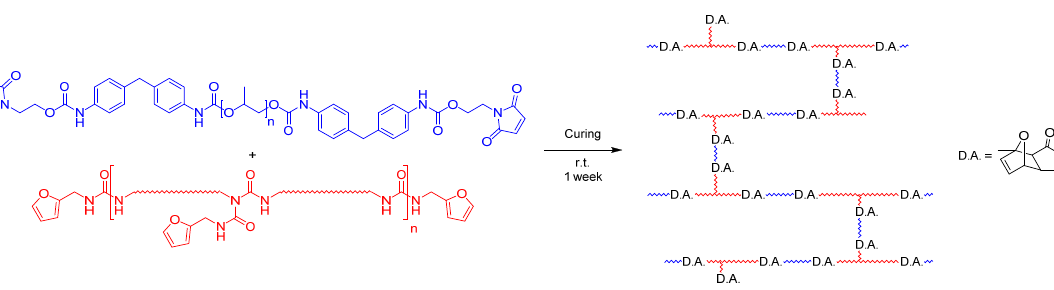
Figure 4. Crosslinking reaction of the two adhesive components during the curing process.